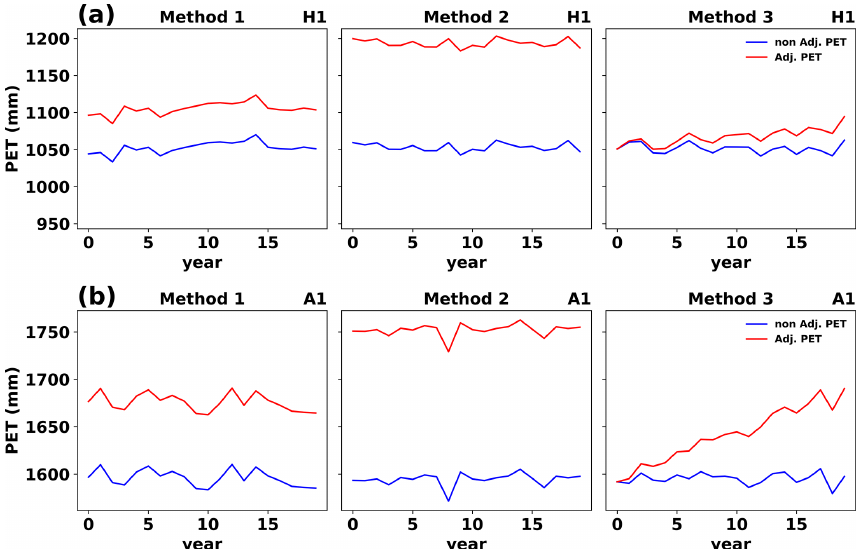
Figure 15. Annual PET estimated using stoPET with the three climate change methods for (a) a humid location (H1) and (b) an arid location (A1) in North America (see Fig.